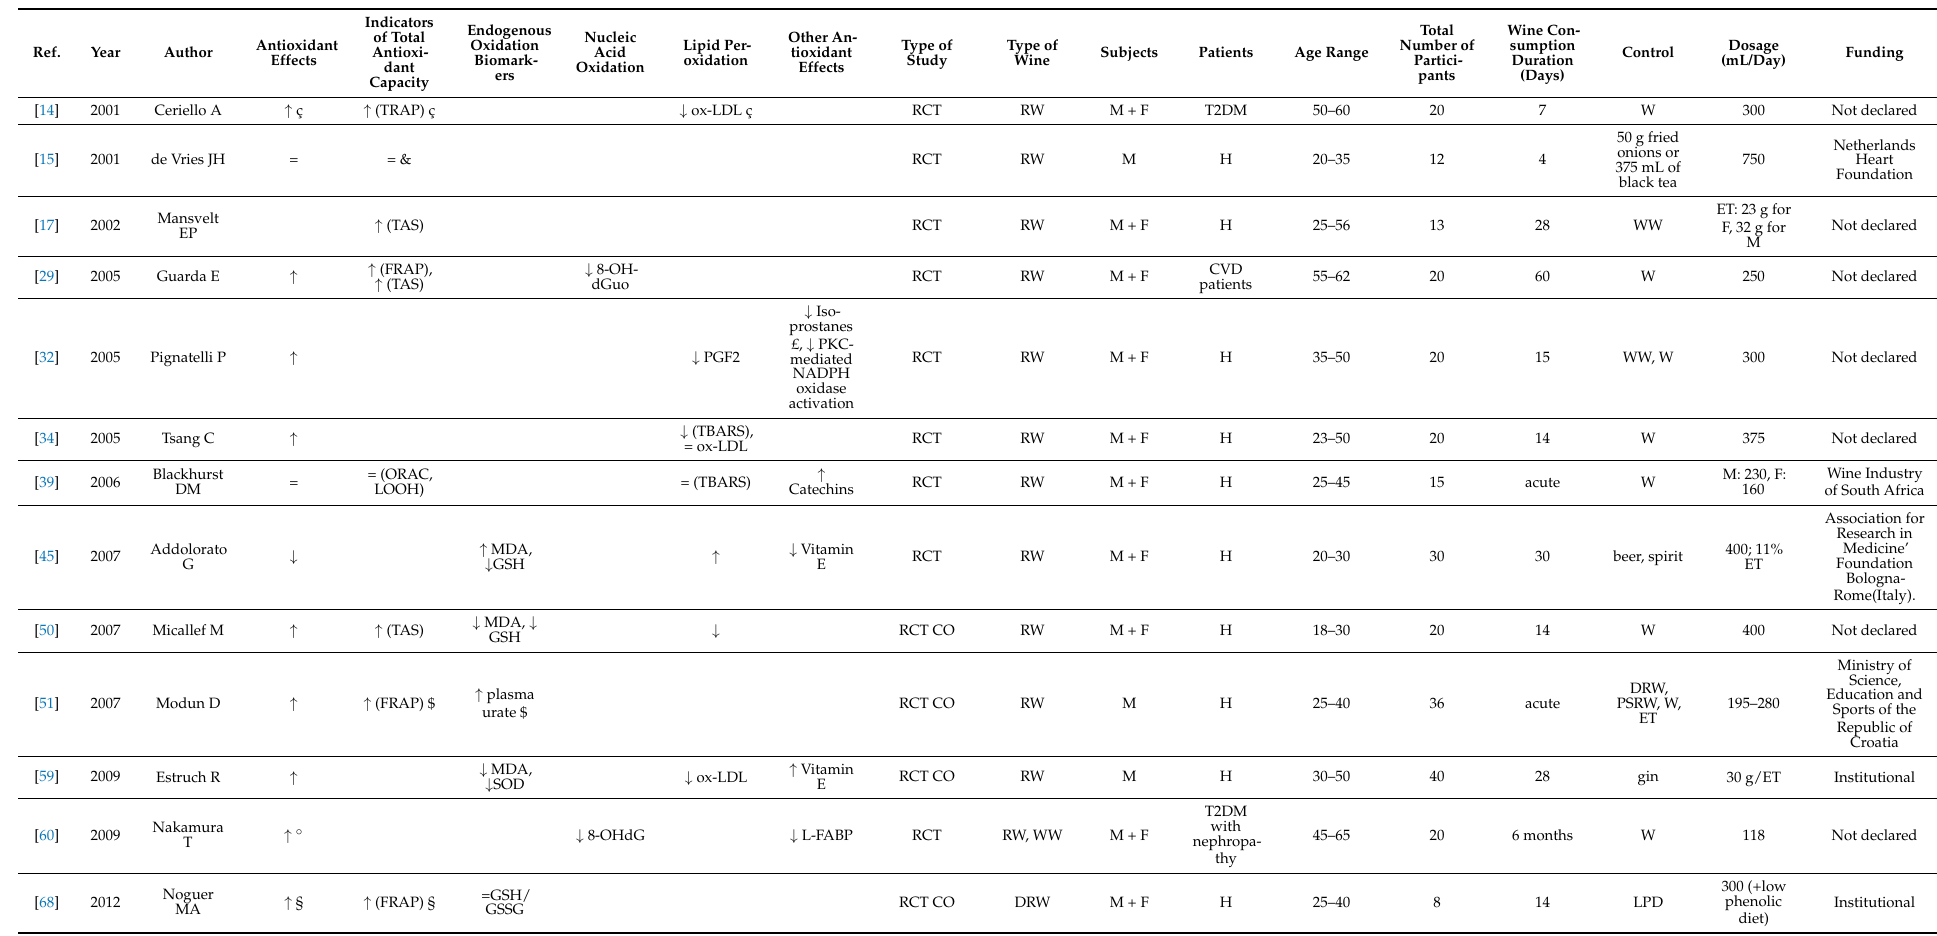
Table 1. Overview of studies that evaluated the antioxidant effects of red wine consumption.